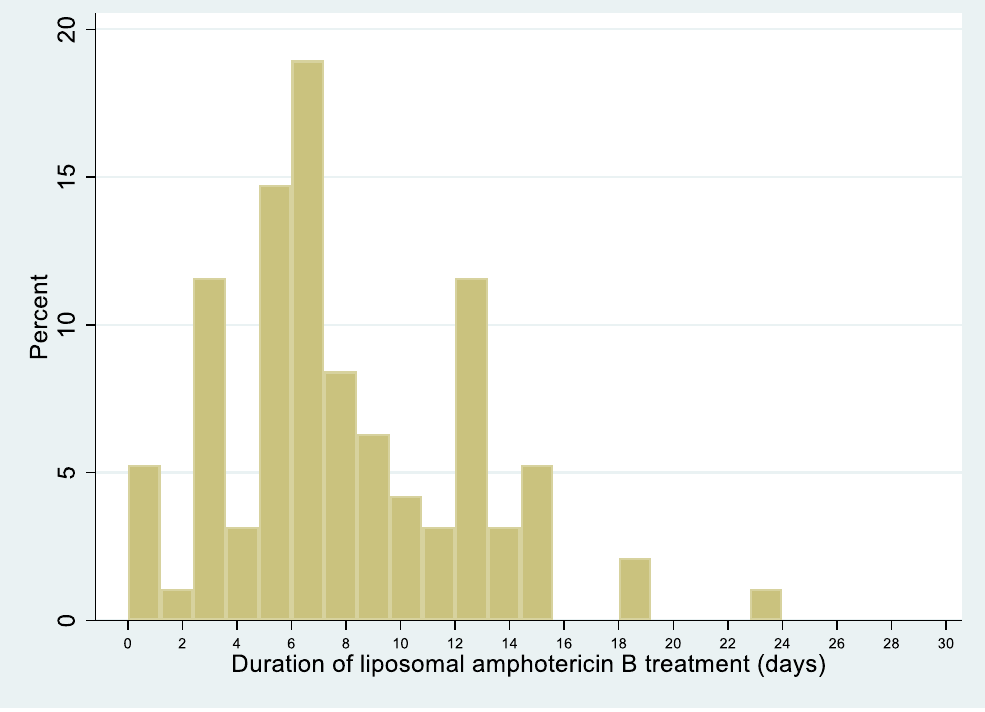
Figure 5. HIV-associated disseminated histoplasmosis: duration of liposomal amphotericin B treatment.